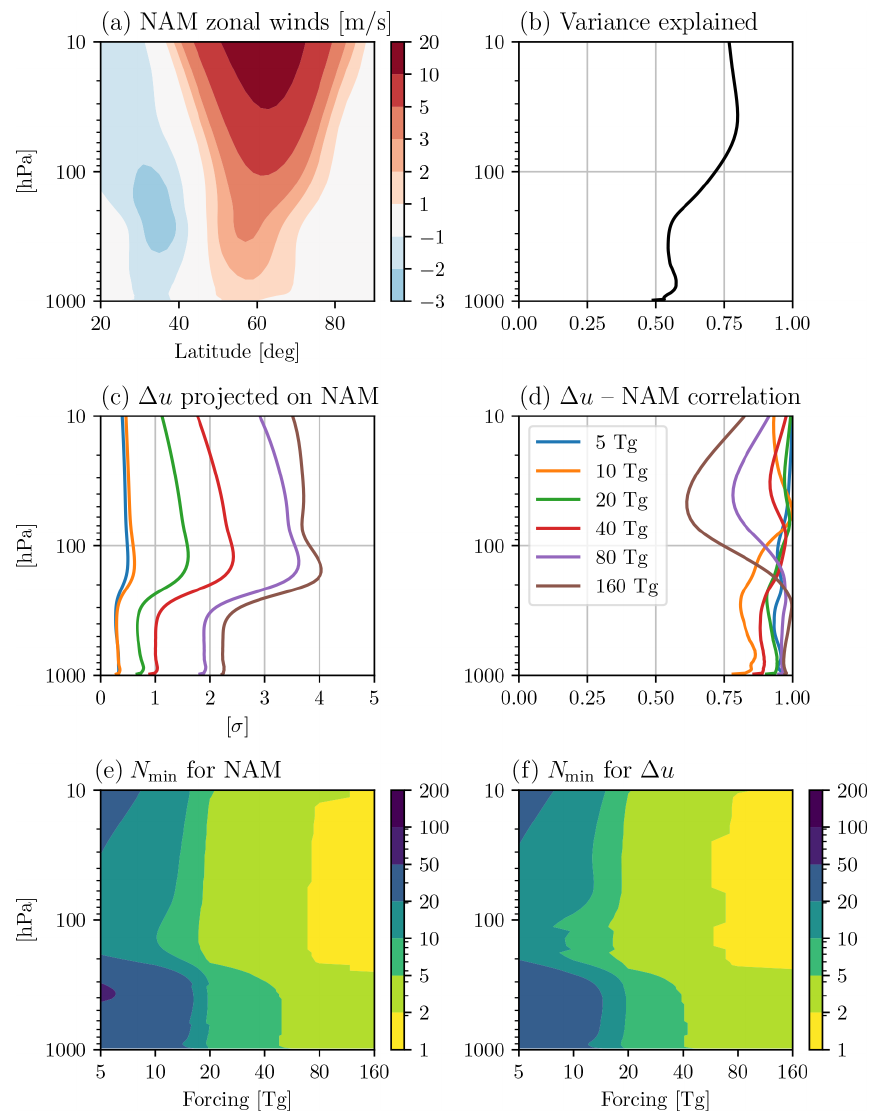
Figure 3. (a) Zonal mean zonal winds associated with 1 standard deviation of the Northern Annular Mode (NAM) in our PI control run (see Sect. 2.6 for details). (b) Fraction of variance captured by the NAM in the control run. (c) Projection of (cid:49)u (Fig. 2, right) onto the NAM, in units of the NAM standard deviation computed from the PI control run. (d) Latitude-weighted correlation of (cid:49)u and the NAM at each level. The legend in (d) also applies to (c) : the colors indicate different injections. (e) Smallest ensemble size ( N min ) necessary for the NAM response to be significant at the 95% confidence level in the first-DJF NAM. (f) As in (e) , but for the spatial pattern of (cid:49)u